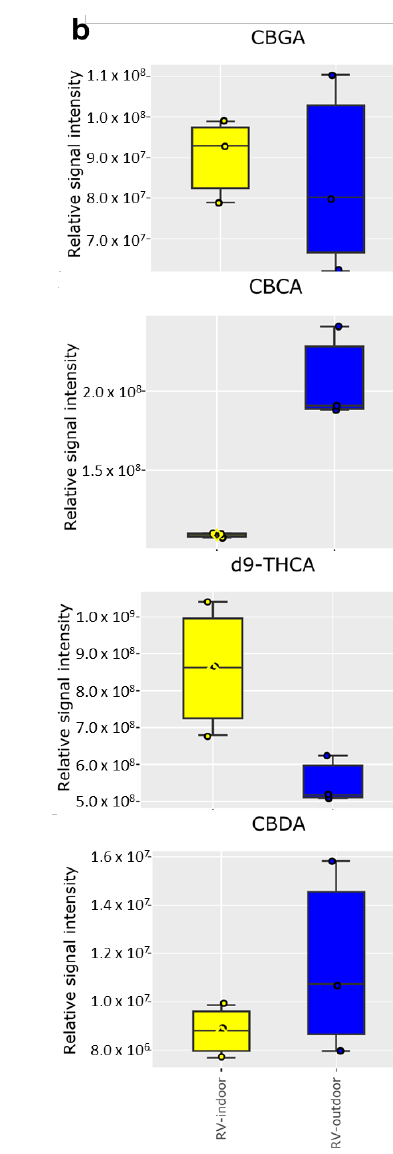
Figure 2. Comparison of the primary, intrinsic cannabinoids, CBGA, CBCA, ∆ 9 -THCA, and CBDA detected by LC-MS analysis in ( a ) CP-indoor and CP-outdoor; ( b ) RV-indoor and RV-outdoor (n = 3 independent samples per group).